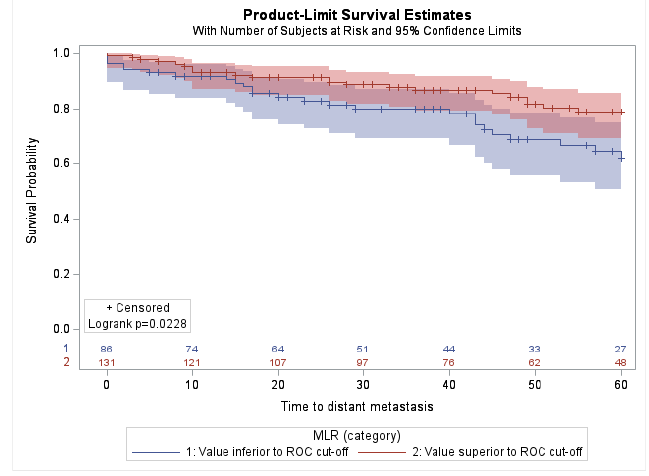
Figure 1. Kaplan–Meier curves for DMFS according to low vs. high MLRs in the study population (n = 217).